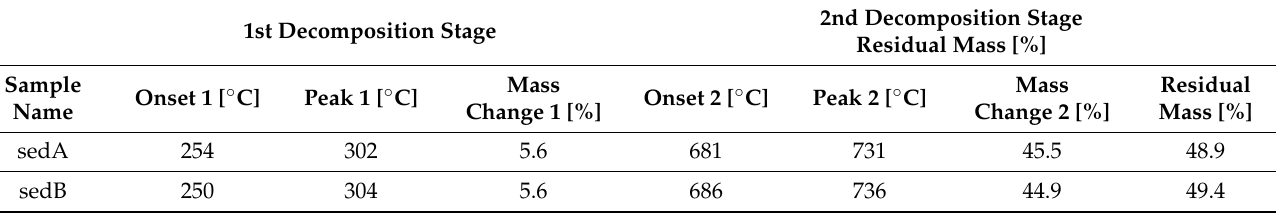
Table 4. Thermal decomposition of raw deposits.